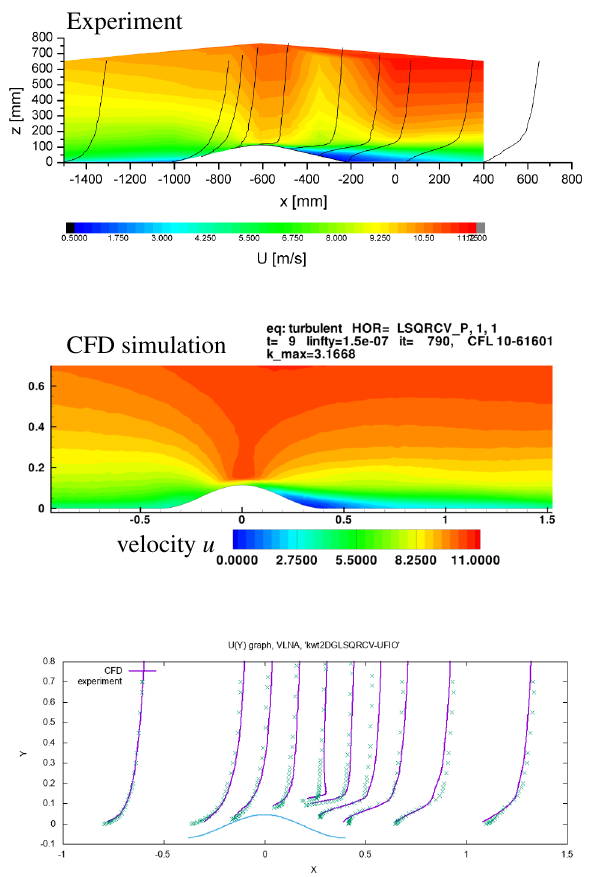
Fig. 3. The flow over the terrain wave: measured horizontal velocity profile at given vertical lines, and numerical simulation. Direct comparison is shown in the bottom